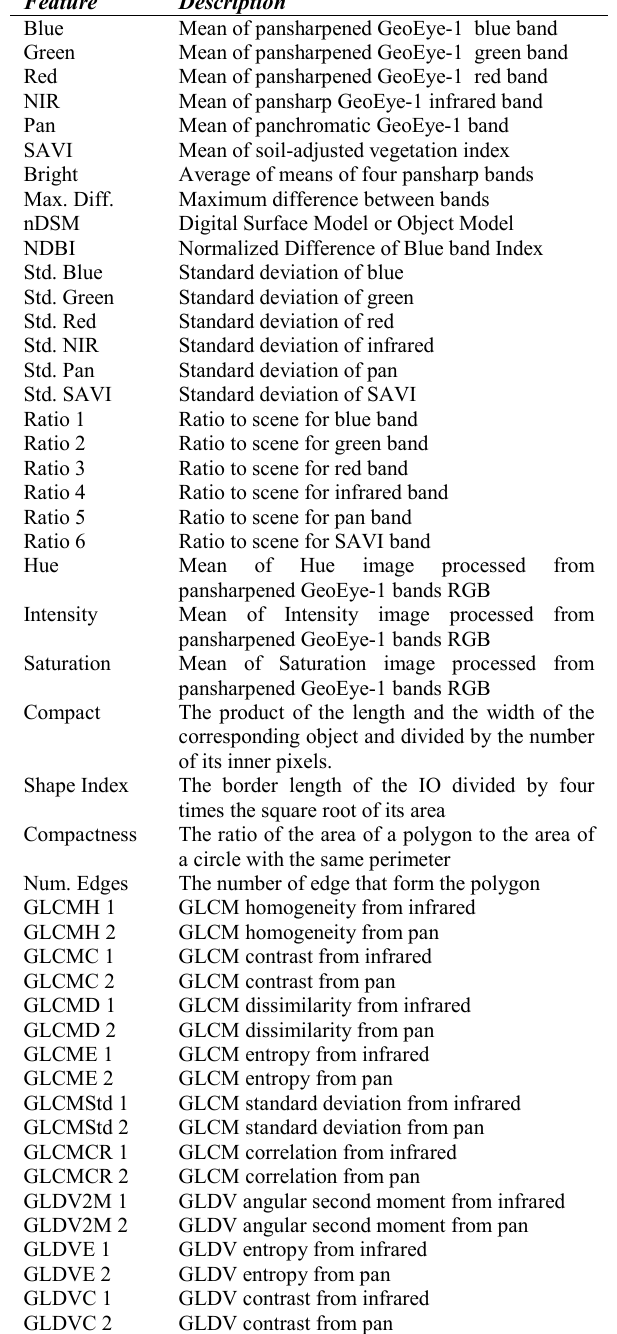
Table 3. Image Object (IO) features used in the classification